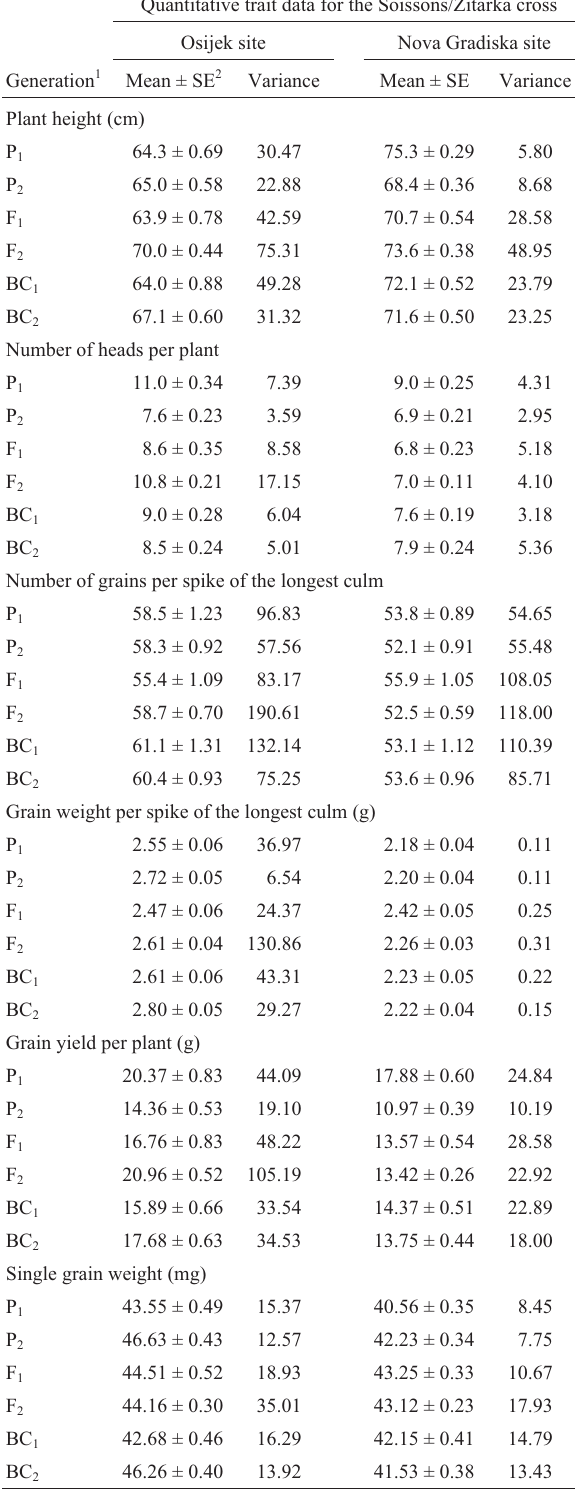
Table 1 - Quantitative trait data for the Soissons/Zitarka cross at the Osijek and Nova Gradiska sites. Quantitative trait data for the Soissons/Zitarka